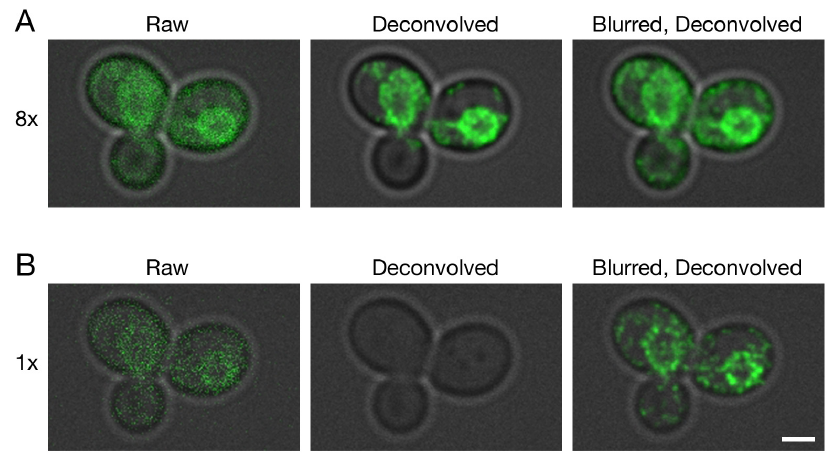
Figure 2. Improved deconvolution of non-punctate fluorescence signals with a Gaussian blur prefilter. Gene replacement in Saccharomyces cerevisiae was used to label ER membranes with Hmg1-GFP (Koning et al., 1996). A confocal Z-stack was captured with line accumulation set to ( A ) 8x or ( B ) 1x. The data were average projected either with no processing, or after deconvolution with Huygens, or after prefiltering with a 2D Gaussian blur using a radius of 0.75 pixels followed by deconvolution. Fluorescence data are superimposed on differential interference contrast images of the cells (gray). Scale bar, 2